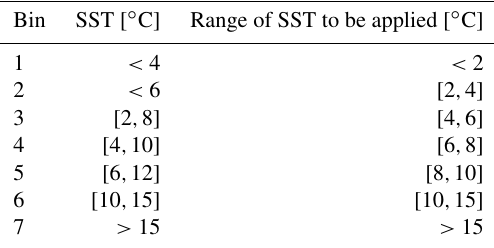
Table 1. Bins of SST for the computation of SMOS-based climato- logical data and the corresponding ranges of SST to be